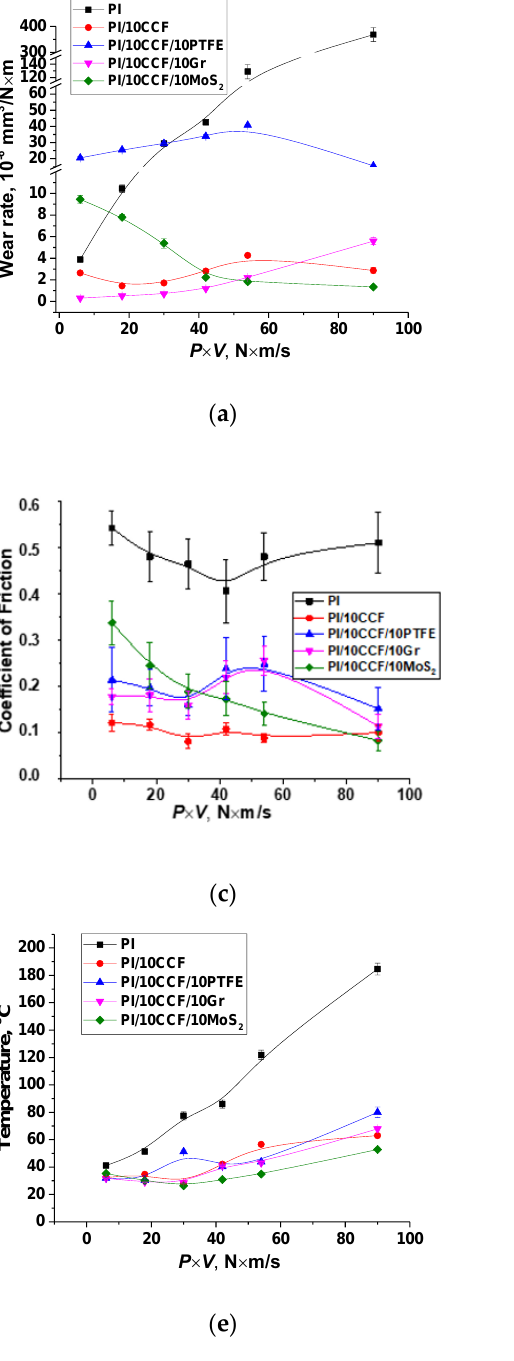
Figure 1. Dependences of the WR values ( a , b ), the CoF levels ( c , d ) and the surface temperatures ( e , f ) from the P · V load-speed parameter for the PI- ( a , c , e ) and PEI-based ( b , d , f ) materials. The ceramic- polymer tribological contact (the ‘ block-on- ring’ scheme). Under the ‘mild’ tribological conditions ( P = 60 N and V = 0.1 m/s), WR values were rather low and comparable for neat PI and PEI (~4 × 10 − 6 and ~2 × 10 − 6 mm 3 /N m, respec- tively). They increased with the raising of the P V product, but the process was much more intensive in the neat PI case. Under the ‘severe’ conditions ( P = 180 N and V = 0.5 m/s), the WR value of neat PEI was 30 times less than that for neat PI. A CoF level of 0.5 was observed for neat PI throughout the studied P V range. At the same time, it was lower for neat PEI and sharply decreased down to 0.18 (Figure 1c, d) only under the ‘se- vere’ conditions. In this case, both PI and PEI surface temperatures wer e quite high, but it was 1.9 times lower on the neat PEI sample (100 C versus 190 C, Figure 1e,f). On the other hand, the PI/10 CCF composite possessed greater wear resistance over the entire studied P V range, compared to that for the PEI/10 CCF one. Additional load- ing with the Gr and MoS 2 fillers exerted an ambiguous effect on this parameter by changing the P V level for the PI- and PEI-based composites. For the PI-based ones, Gr was more efficient at low P V values (up to 40 N m/s), while MoS 2 showed a better effect above this level. Under these test conditions, the CoF level of the ternary composites based on both matrices was close (about 0.1 according to Figure 1c,d). A similar pattern was observed for their surface temperatures, although it was evidently lower for the PEI/CF sample (Figure 1e,f). Note that PTFE was not effective filler for the composites based on both matrices in the ceramic-polymer tribological contact. According to the authors, this was due to the fact that it did not contribute to the formation of a stable TL on the composite wear track surfaces (discussed in more detail below). In doing so, the chemical nature of PI and PEI played a decisive role in the tribolog- ical characteristics, mainly for the neat polymers in the ceramic-polymer tribological contact in the entire studied range of the P V product. For the PI/10CCF and PEI/10CCF composites, additional loading with the Gr and MoS 2 fillers determined the different pattern of wear resistance at the low P V levels (up to 40 N m/s) through the different pattern of the TL formation. Above this P V level, wear resistances of the binary and ternary composites were close in magnitude at the nearly equivalent CoF values. Below, the wear track surfaces and the CoF time dependences are presented for the studied materials tested under the ‘mild’ (Figure 2) and ‘severe’ (Figure 3) conditions. Their analysis from the standpoint of the TL formation enabled us to evaluate the key factors influencing their structures as a factor determining wear resistance. It should be noted that the solid lubricant fillers did not perform their function, but rather played the role of a TL structure modifier under the applied tribological test conditions (the linear